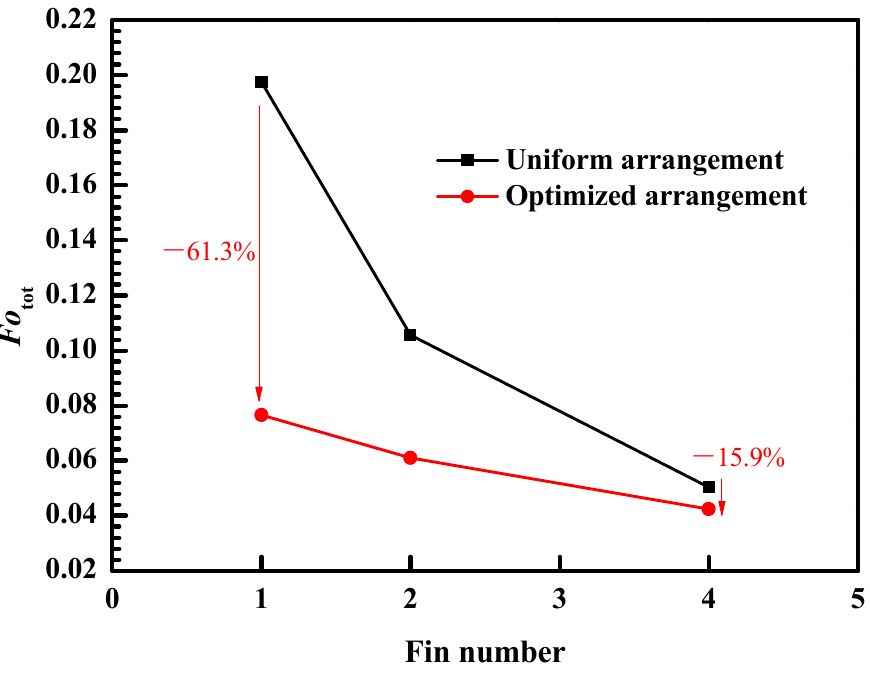
Figure 17. Variation of dimensionless total melting time, Fo tot , with the number of